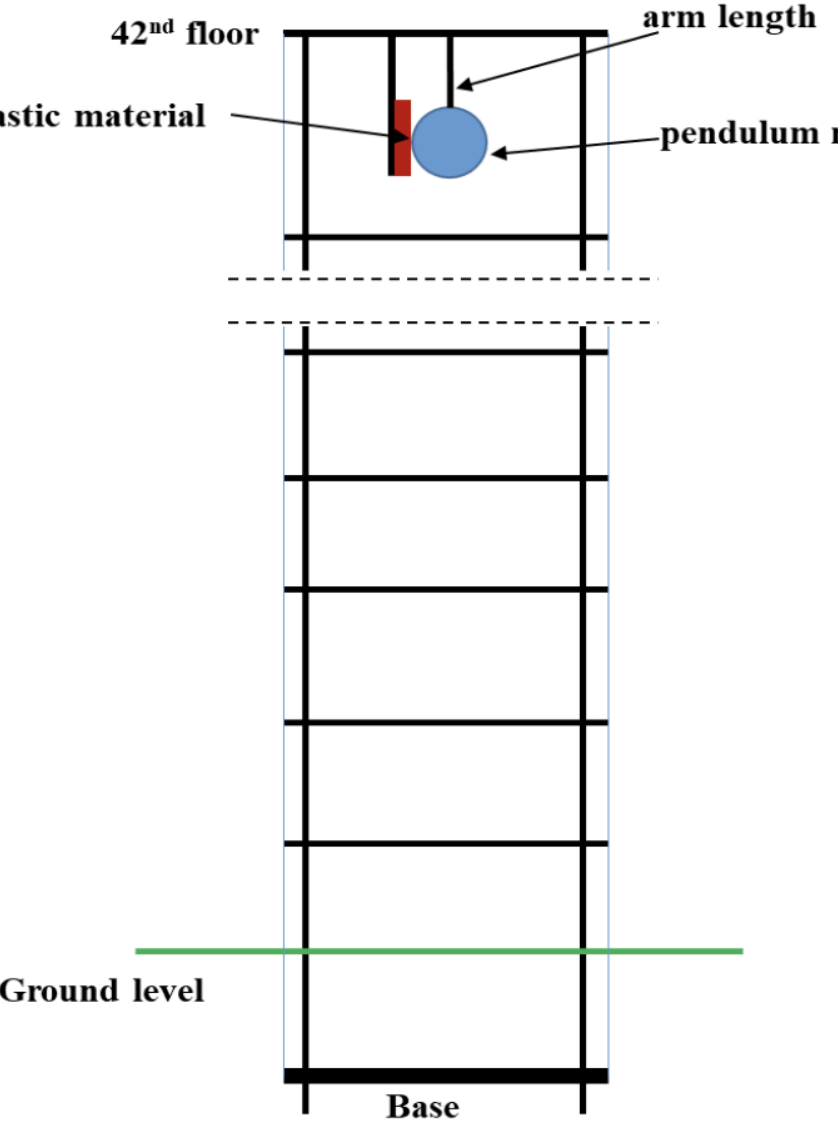
Figure 14. Schematic representation of a high-rise building equipped with a pendulum PTMD.